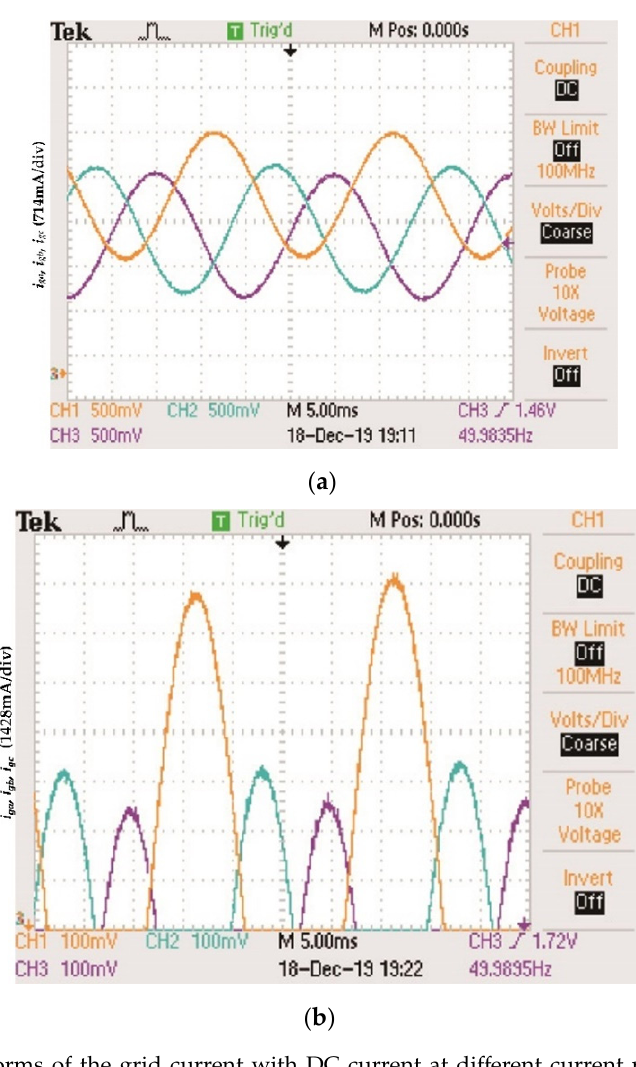
Figure 7. Waveforms of the grid current with DC current at different current references without suppression control. ( a ) i ref = 1 A . ( b ) Zoom-in detail of Figure 6a.